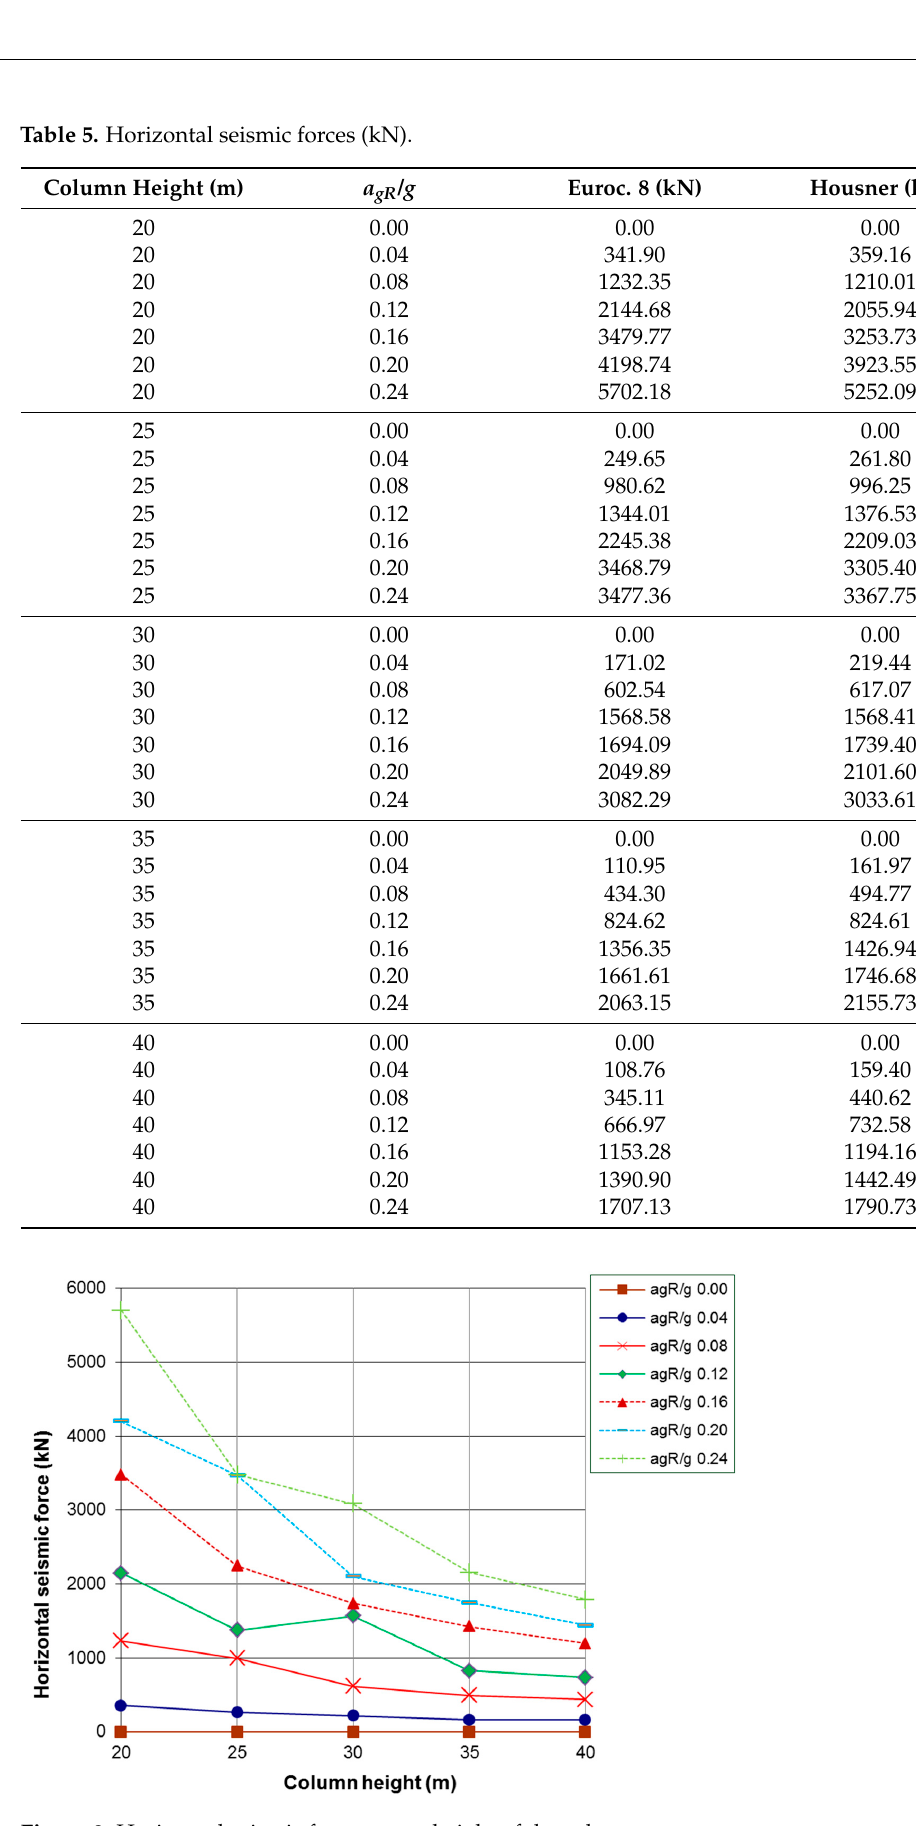
Figure 8. Horizontal seismic force versus height of the column.